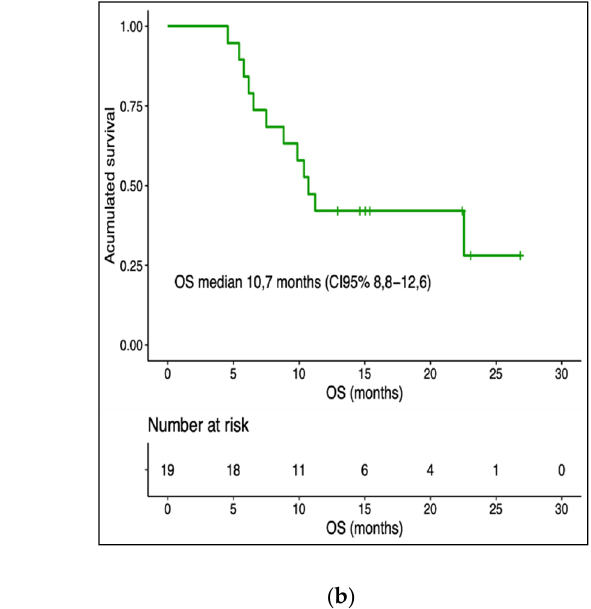
Figure 1. Kaplan–Meier. ( a ) Progression-free survival analysis. ( b ) Overall survival analysis.